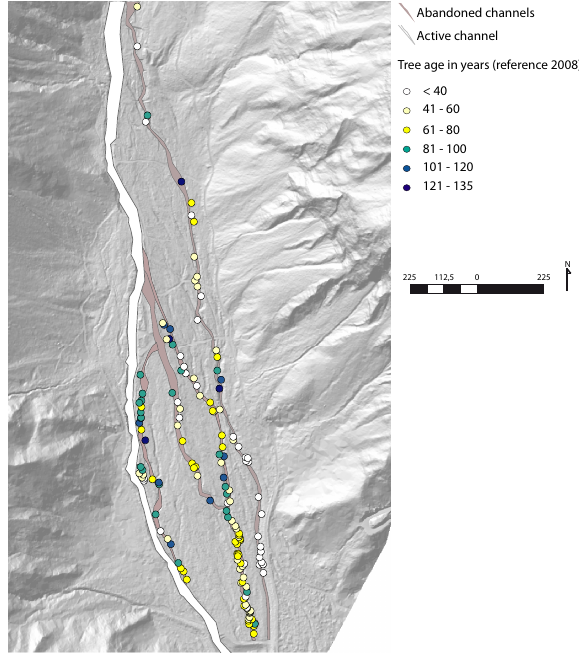
Fig. 5. Age structure of the forest stand at the study